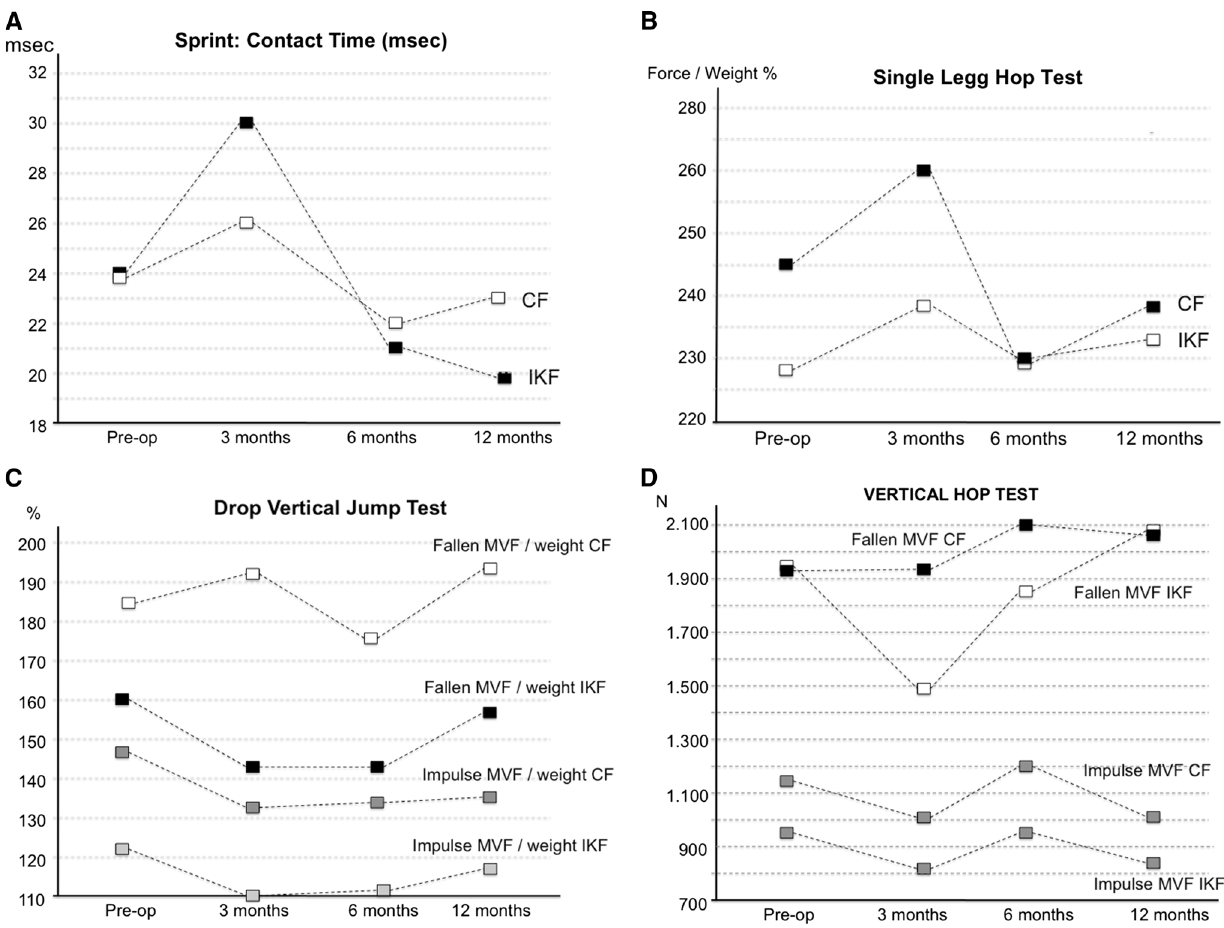
Fig. 4 a Sprint kinetics, b single-leg hop test kinetics, c drop vertical jump kinetics, d vertical hop test kinetics. IKF injured-knee foot, CF control foot, Pre-op